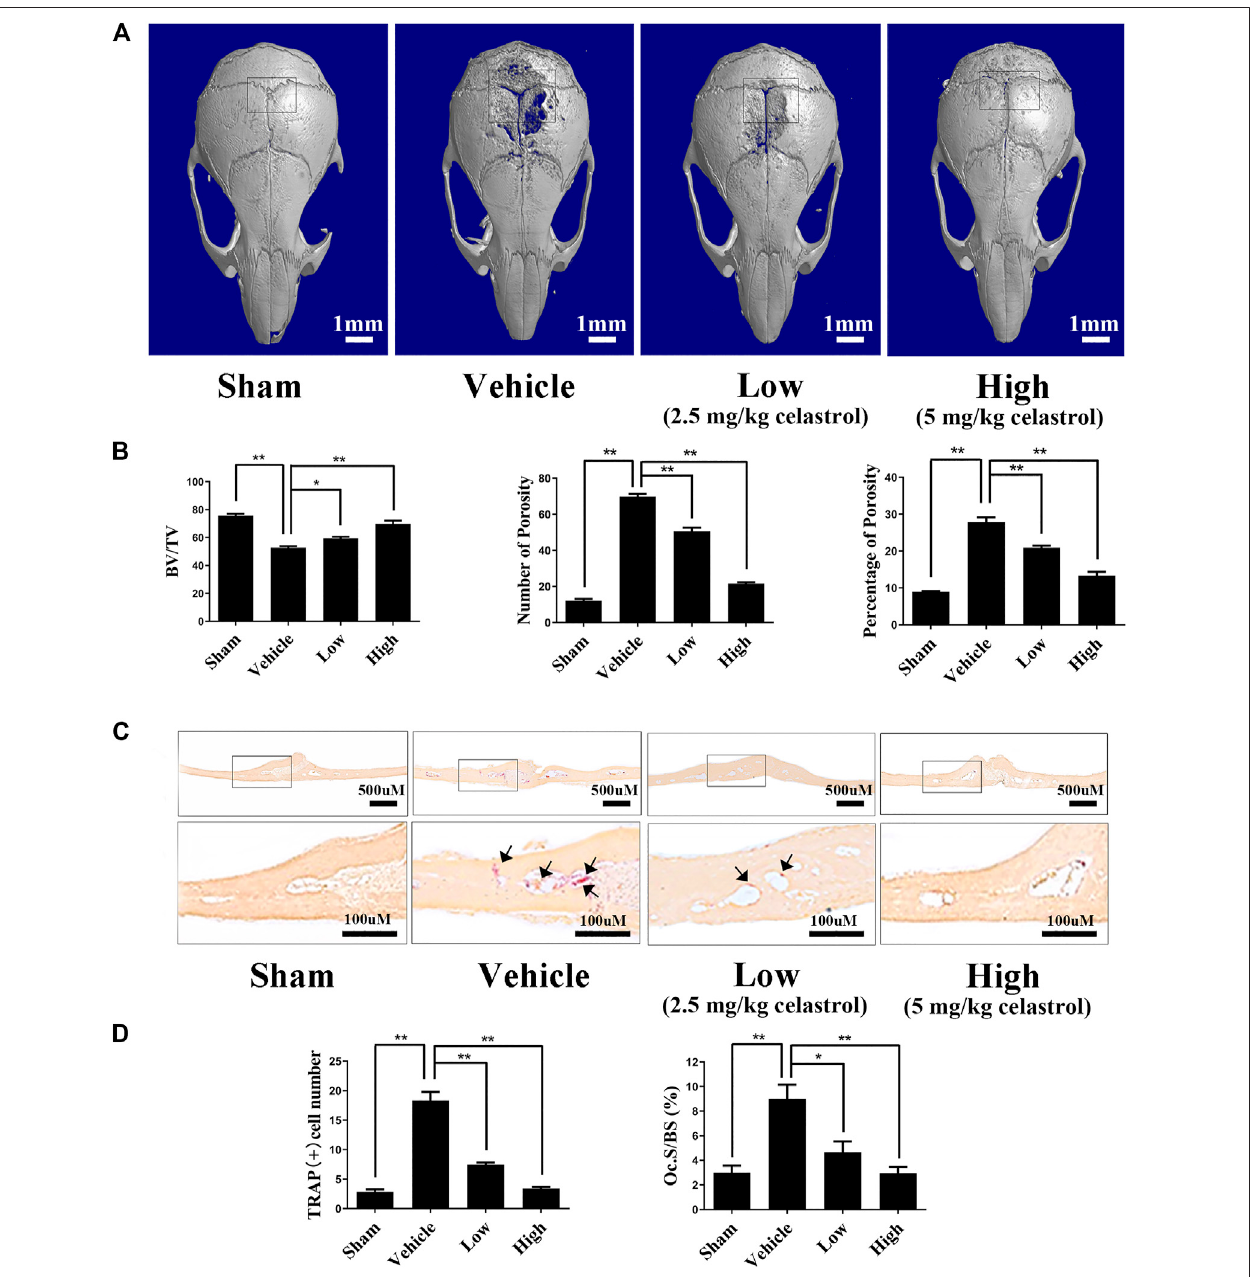
FIGURE 5 | Celastrol prevented the osteolysis caused by titanium particles in vivo. (A) Representative micro-CT 3D reconstructed images were obtained for each group. (B) The number and percentage of porosity were calculated for each sample. (C) Histological assessment of Ti particle-induced mouse calvarial osteolysis with tartrate-resistant acid phosphatase (TRAP) staining. (D) TRAP-positive cell number and the osteoclast surface to bone surface area (Ocs/BS) were evaluated for each group. All experiments were carried out three times, and all data are showed as the means ± SD; * p < 0.05, ** p < 0.01.